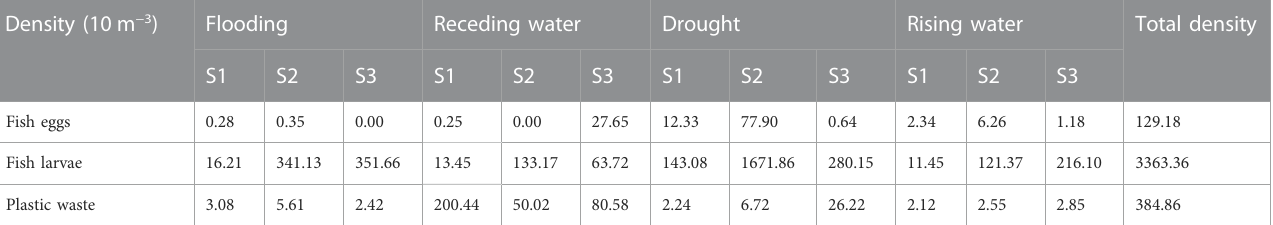
TABLE1Total density (10 m − 3 )of ichthyoplanktonandplasticwastealong thehydrological phasesandsectors ofthe TapajósRiver,Amazon Basin, Brazil.S1:Sector1; S2: Sector 2 and S3: Sector 3. Density (10 m − 3 )